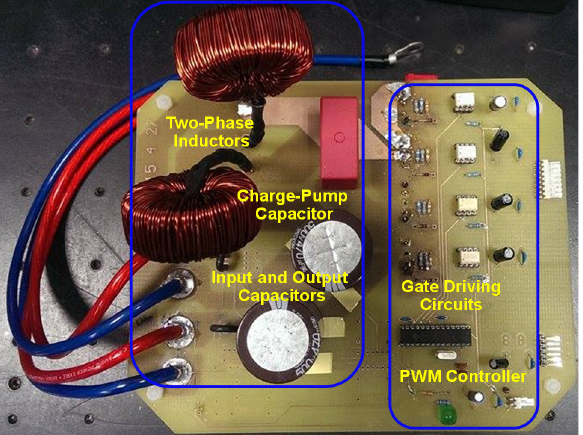
Figure 23. Waveforms of transient response for load period steps in charge mode from 500 W to 250 W and then back to 500 W: ( a ) by simulation; and ( b ) by measurement.